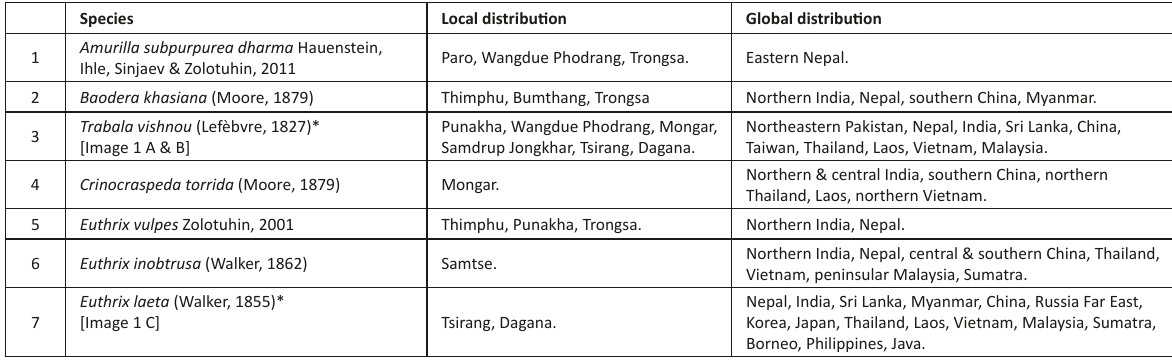
Local distribution Global distribution